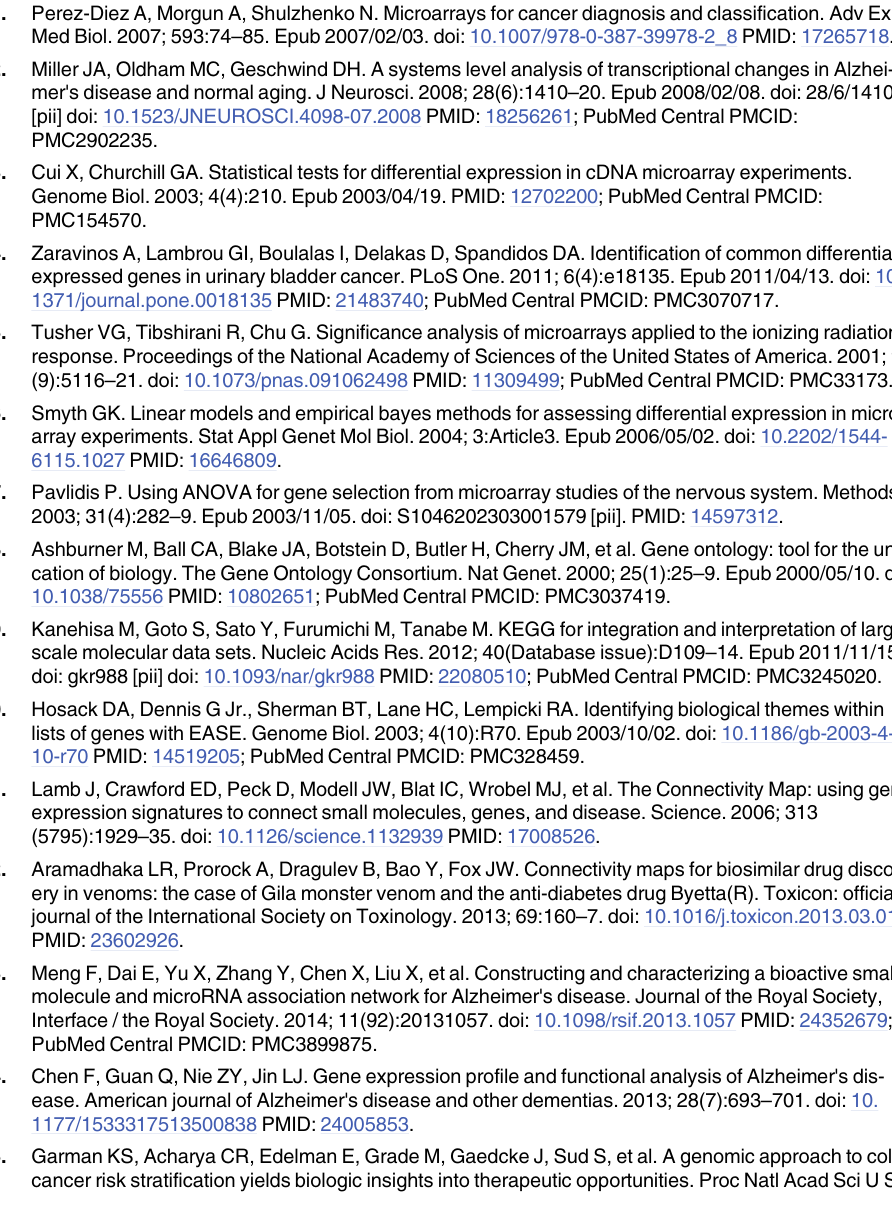
S4 Table. The 4884x1309 GSCMd matrix used to construct the two-way cluster in Fig 3B. GSCMd is the 4884 by 1309 similarity matrix of the 4884 largest ES variance MSigDB tags against the 1309 drugs/chemicals in CMap v2.0 (http://figshare.com/download/file/2258033).